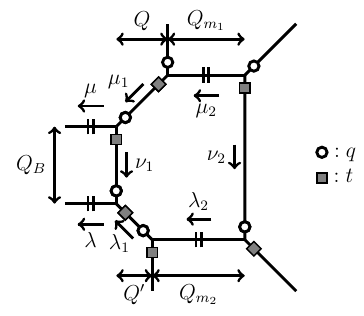
Figure 25 . Another 5-brane web for a theory which is S-dual to the SU(2) gauge theory with two